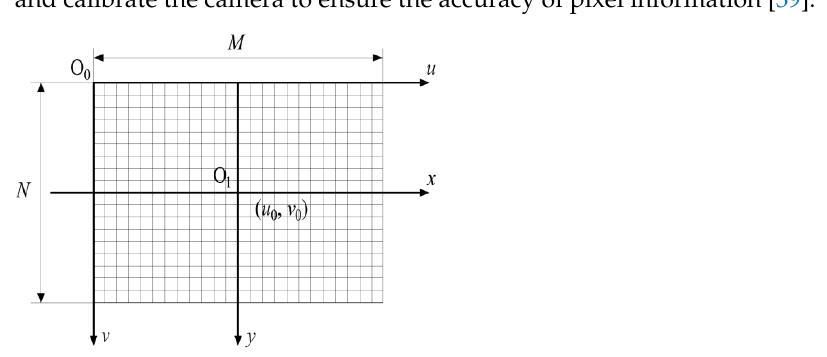
Figure 4. Image coordinate system.